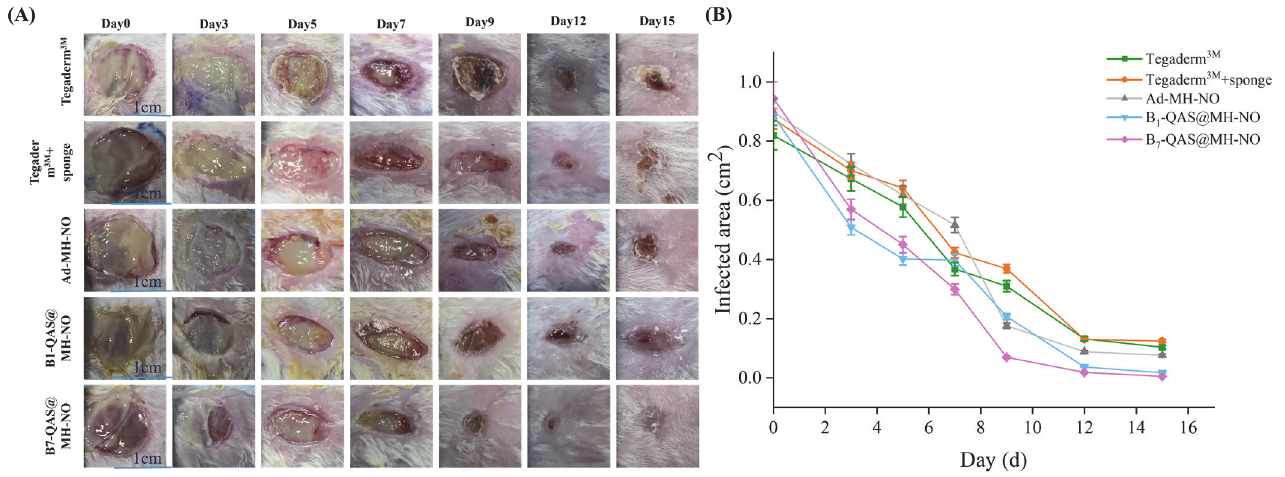
Figure 9. ( A ) Images of exposed abscesses treated with Tegaderm 3M (control), Tegaderm 3M + sponge, B 7 -QAS@MH-NO, B 1 -QAS@MH-NO, Ad-MH-NO and ( B ) Infected area at day 0, 3, 5, 7, 9, 12, and 15.